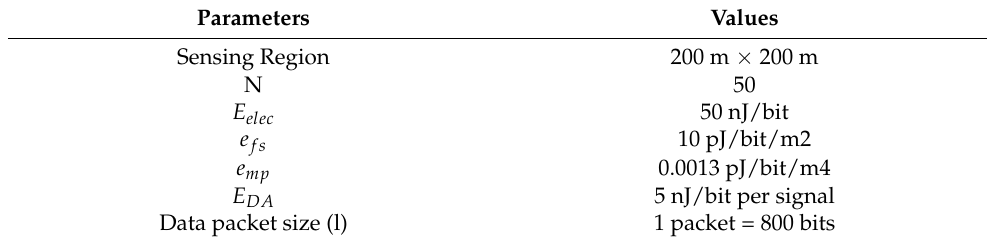
Table 6. Computation parameters and